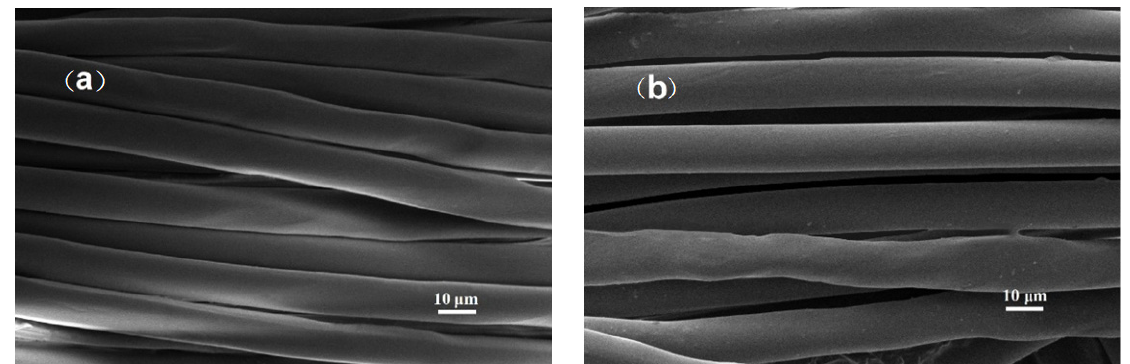
Figure 6. SEM images of pristine cellulose ( a ) and cyclic imide N -halamine polysiloxane@cellulose ( b